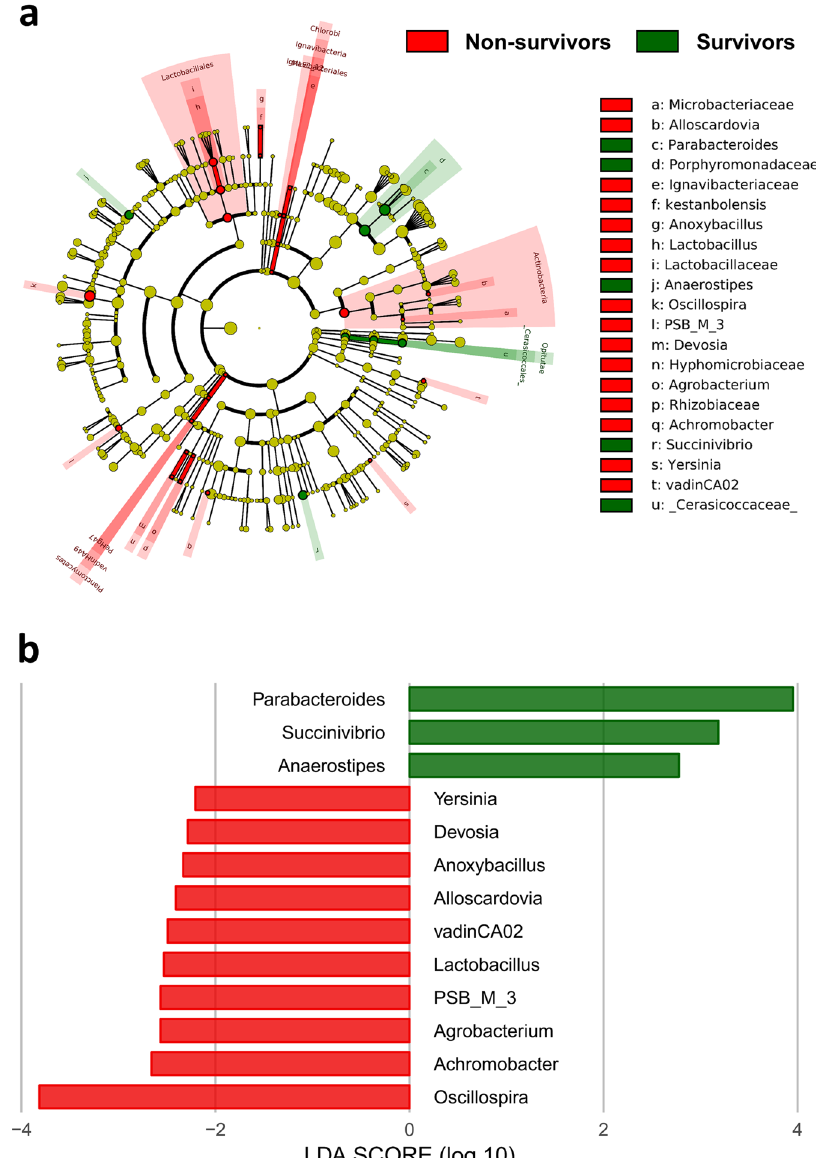
Fig. 4 Cladogram showing differentially abundant taxa of the gut microbiota. a Differential taxon features at the genus level identi fi ed by LEfSe according to nonsurvivors and survivors after matching (LDA score >2). b Red and green bars represent taxon features with signi fi cantly higher expression in nonsurvivors and survivors, respectively. LDA linear discriminant analysis, LEfSe linear discriminant analysis effect